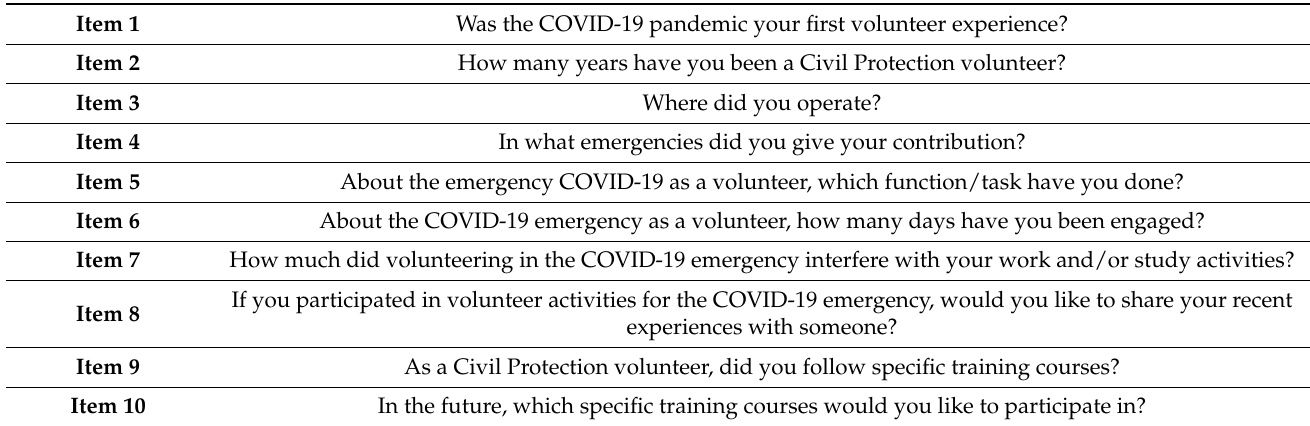
Table 1. Items of the survey’s second section related to the Civil Protection volunteer experiences. Item 1 Item